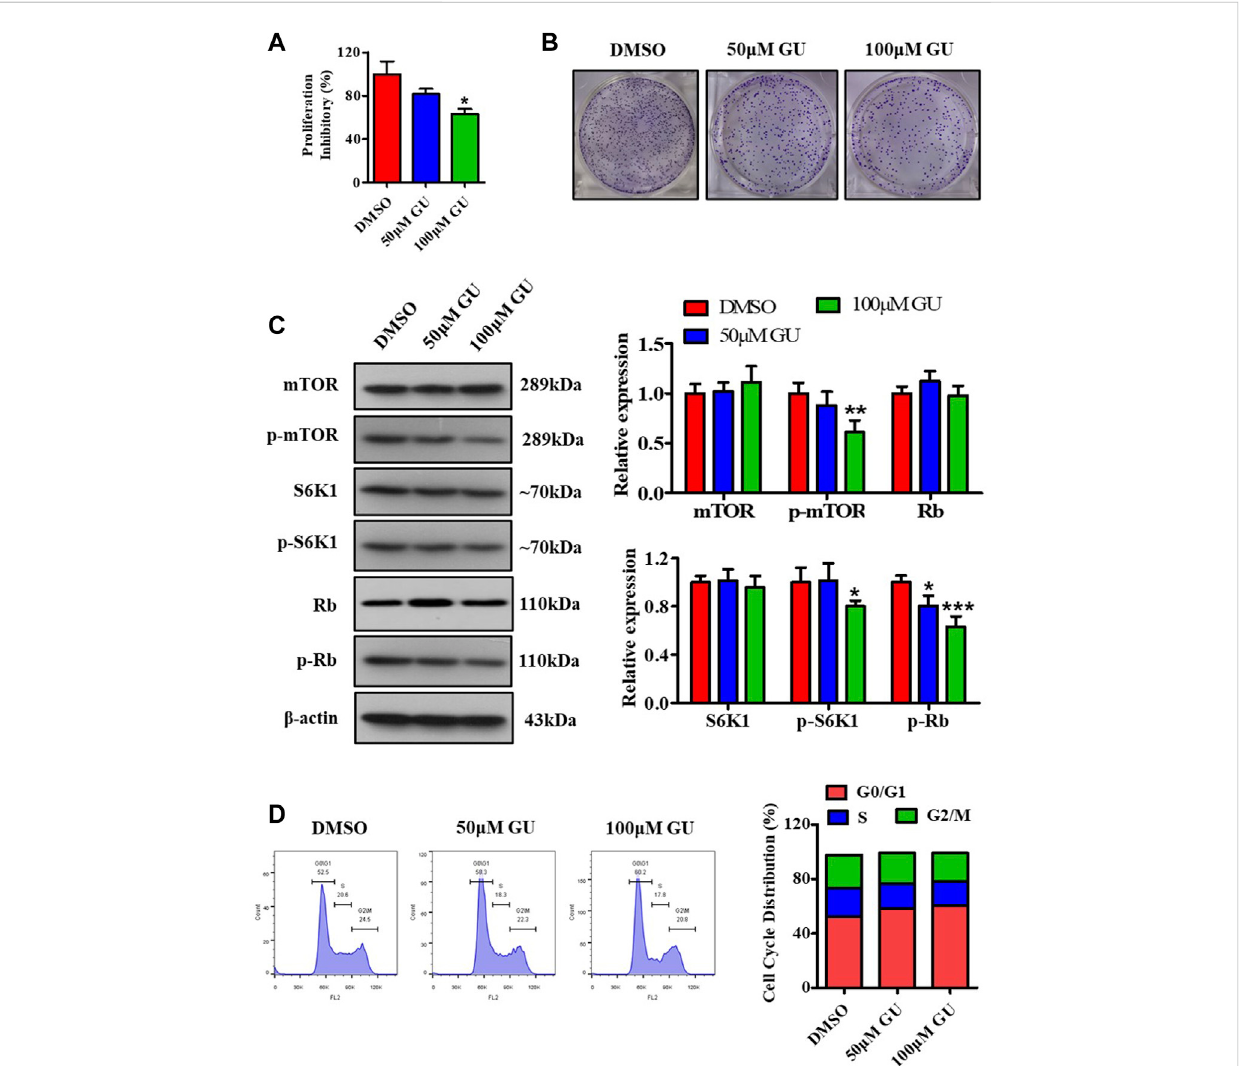
FIGURE 3 GUDCA suppresses the cellular proliferation in HepG2 cells. (A) MTT assay for cellular proliferation. (B) Clone formation experiment to assess the clone number. (C) Western blot for probing the expression of mTOR, p-mTOR, S6K1, p-S6K1, and p-Rb. (D) Flow cytometry for detecting cell cycle distribution. * p < 0.05 and ** p < 0.01 vs. DMSO group. GU means Glycoursodeoxycholic acid